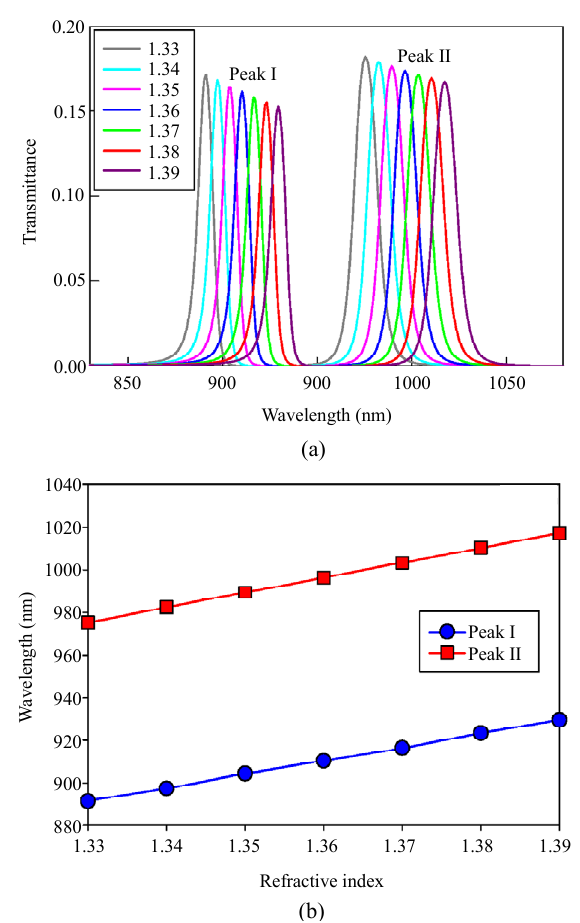
Fig. 8 Refractive index sensing performance of our proposed device: (a) transmission spectra of the proposed device for different refractive indices of the liquid analytes filled in FRC and ARC and (b) the resonance peak wavelengths versus analyte refractive index change for L arc =210 nm.